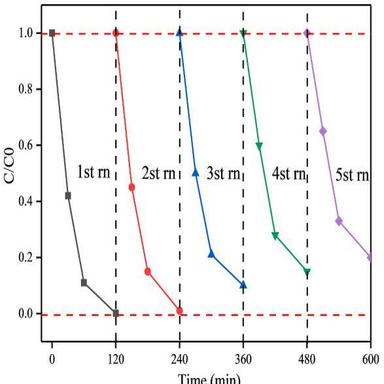
Cyclic Regeneration Experiment of Bi–O-A (Test condition: initial arsenic concentration 10 mg/L, dosage 0.5 g/L, stirring speed 400 rpm, reaction 120 min, T = 25 ± 1 ◦C).